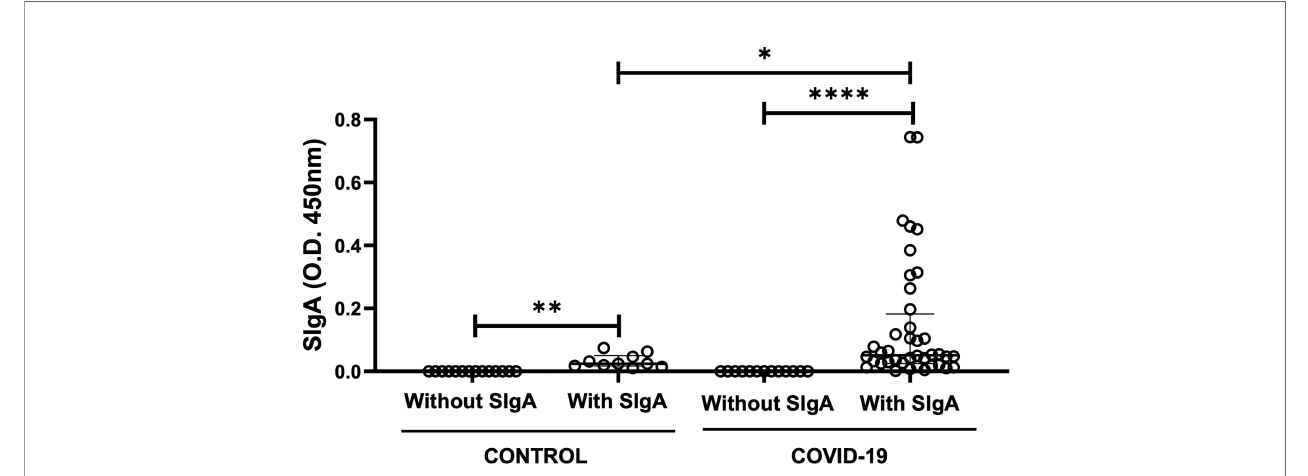
FIGURE 1 | Comparison of the levels of salivary speci fi c-SIgA for SARS-CoV-2 between control and COVID-19 groups with or without the presence of SIgA. The level of signi fi cance was established at 5% (* p < 0.05; ** p < 0.05; **** p <